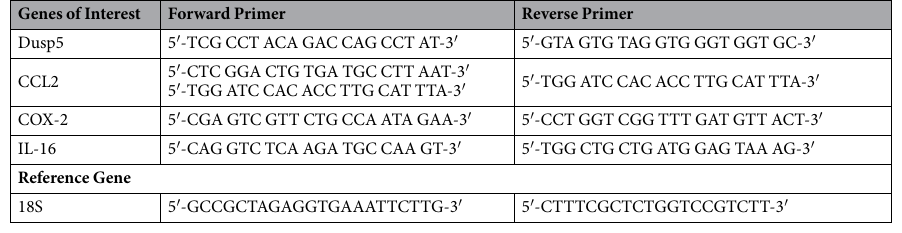
Table 2. Primer sequences used for qPCR in this